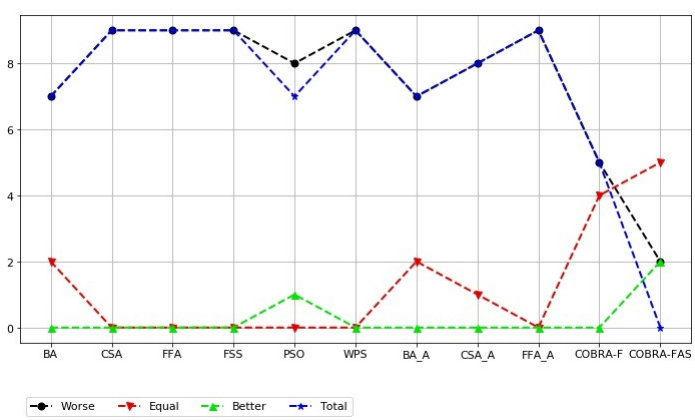
Figure 4. Results of the Mann-Whitney statistical test with p = 0.01, comparison of COBRA-SHA with other approaches (SET-2, D = 10).